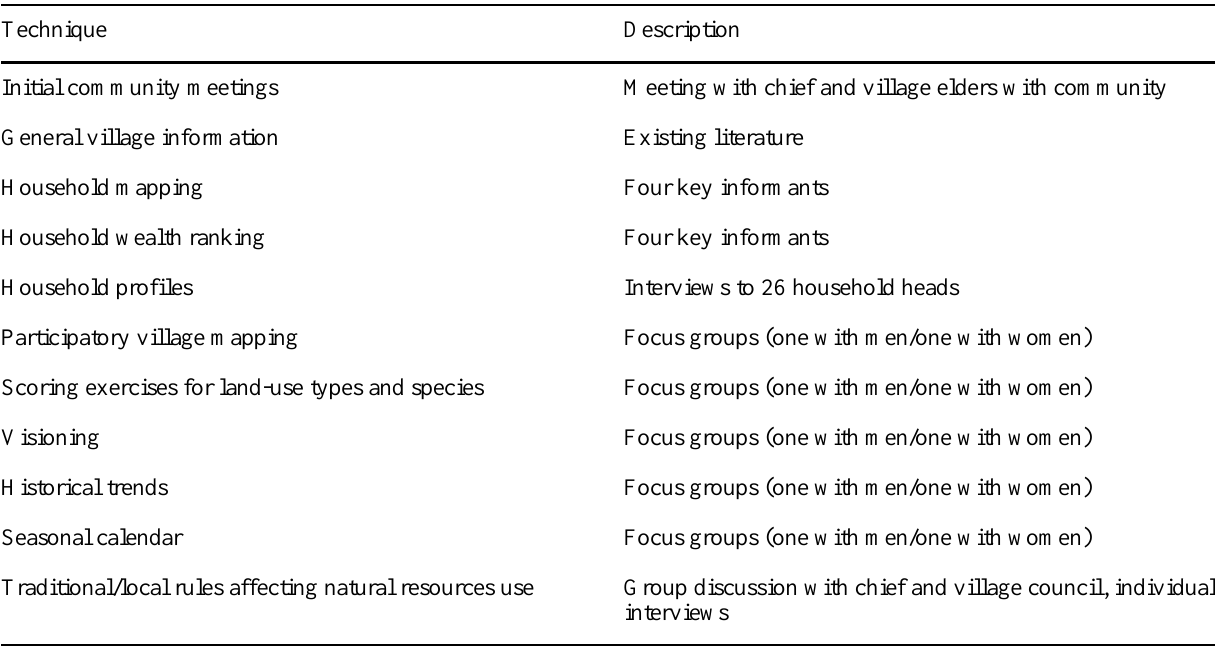
Table 2. Data collection techniques used in